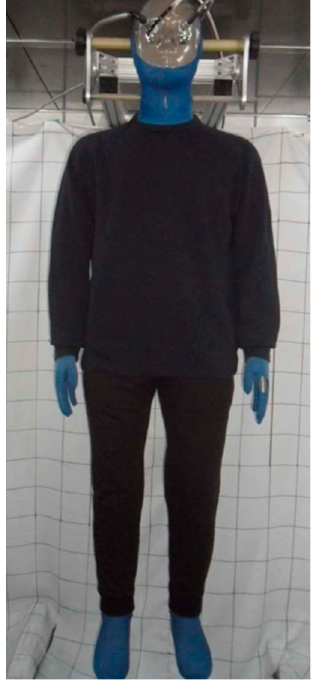
Figure 5. Evaluation of the clo level using a manikin with winter clothing.